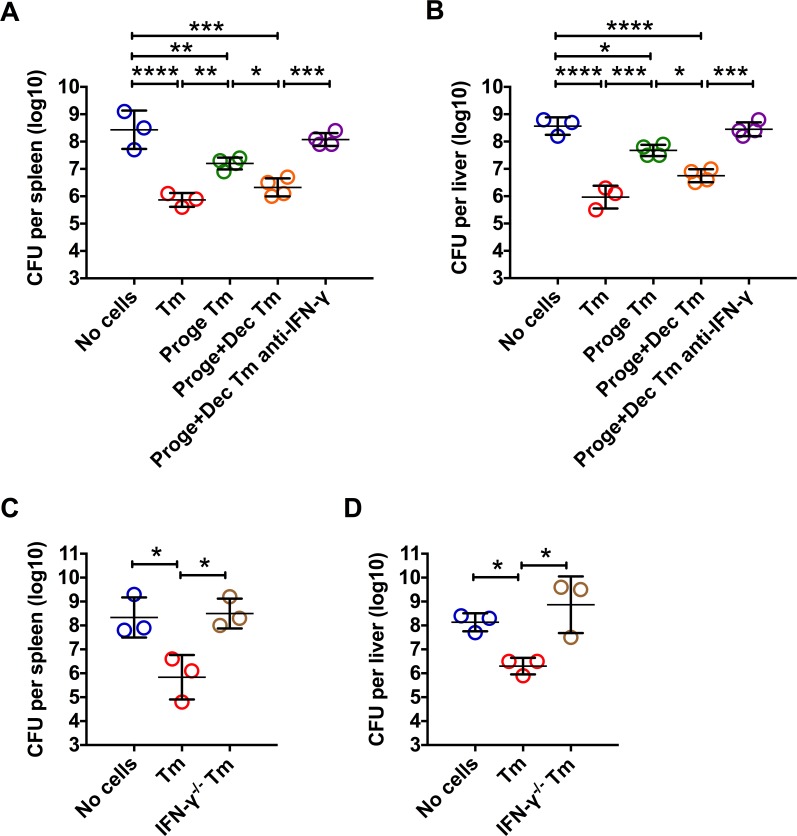
Dependence of IFN-γ in progesterone-induced impairment of protection by antigen-non-specific CD8 Tm cells.CD8 Tm cells were generated by immunization with rAdHuOVA in C57BL/6 mice (Tm) or IFNG-/- mice (IFN-γ-/- Tm). At 40 days post immunization, some immunized C57BL/6 mice were injected with progesterone(Proge) for 2 weeks, with or without decitabine(Dec) treatment. OVA antigen-specific CD8 Tm (Tm or IFN-γ-/- Tm) cells purified from the spleen and MLN were adoptive transferred into naïve IFNG-/- mice followed by LM infection. Some mice adoptive transferred with CD8 Tm cells were treated with anti-IFN-γ neutralizing antibody before and after infection. Bacterial CFU numbers in the spleen (A and C) and the liver (B and D) at 72 hours post infection are shown. Error bars represent mean±SD. One-way ANOVA and Tukey’s multiple comparisons test was used to compare between multiple groups. * P<0.05; ** P<0.01; *** P<0.001; **** P<0.0001. Data in (A) and (B) are representatives of 2 independent experiments with n = 3 to 4 per group. Data in (C) and (D) are representatives of 2 independent experiments with n = 3 per group.